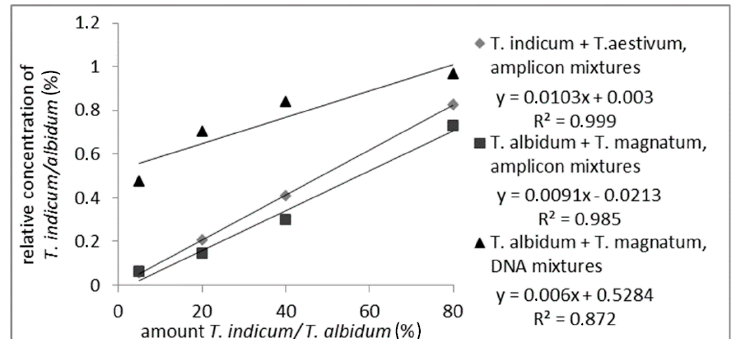
Figure 2. Standard curve of PCR-amplicon mixtures from T. indicum with T. aestivum and T. albidum Pico with T. magnatum with 5%, 20%, 40%, 80% T. indicum/albidum Pico and standard curve of DNA mixtures from T. albidum Pico with T. magnatum with 5%, 20%, 40%, 80% T. albidum Pico. The detected relative areas of PCR-amplicons are plotted against T. indicum or T. albidum Pico amount.